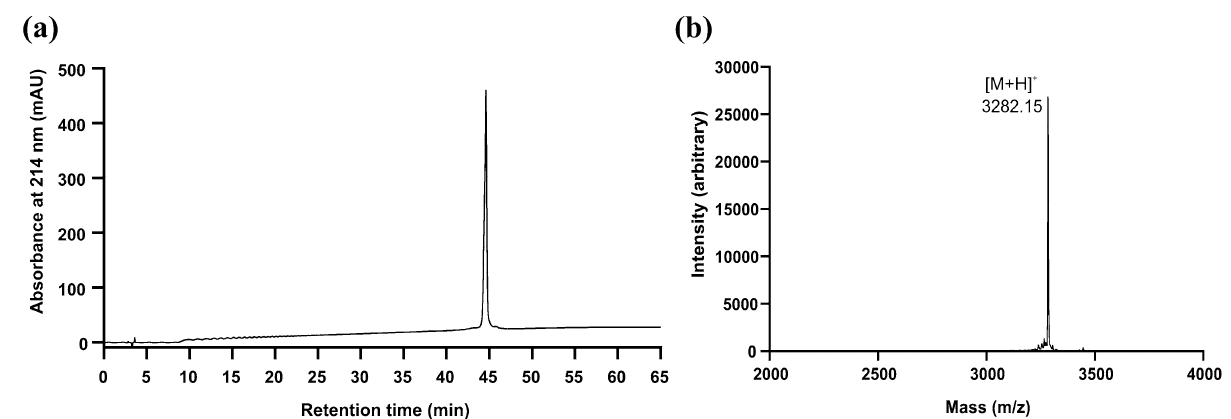
Figure 4. Analytical profile of native caripe 11 cyclotide isolated from C. ipecacuanha . The quality control using RP-HPLC ( a ) and MALDI TOF MS ( b ) with yielded 99.8% purity, whereas labeled m/z refers to monoisotopic [M + H] + ion.